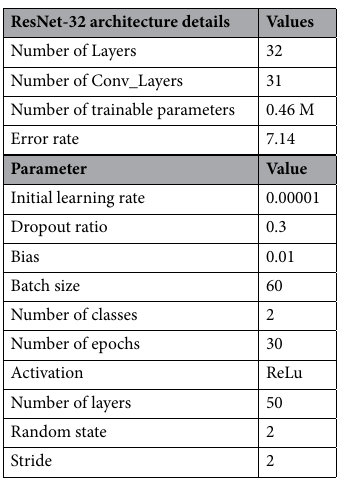
Stride 2 Table 4. Details of network parameters used in the evaluation.